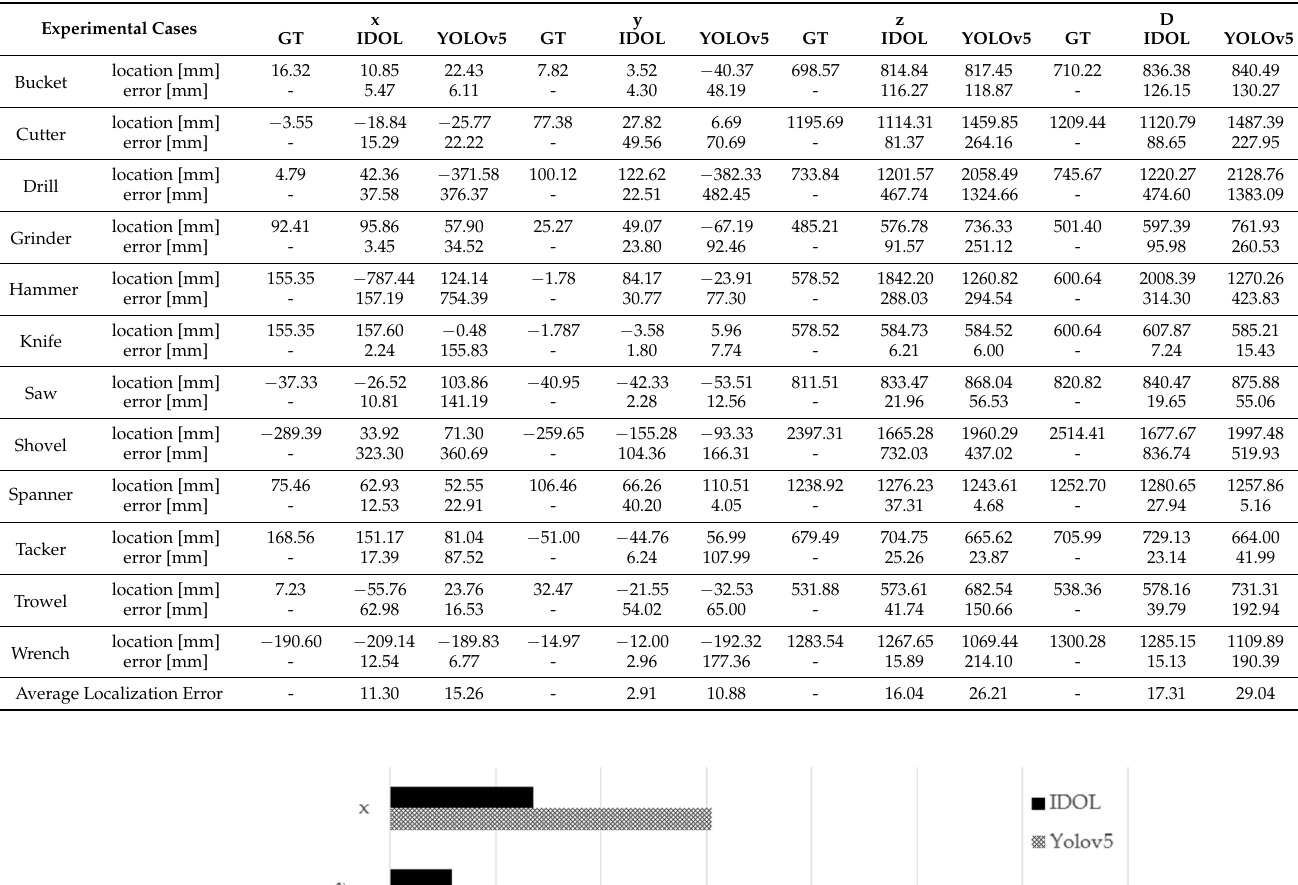
Table 3. Localization errors of the IDOL and YOLOv5 in (x, y, z) and (D) coordinates.